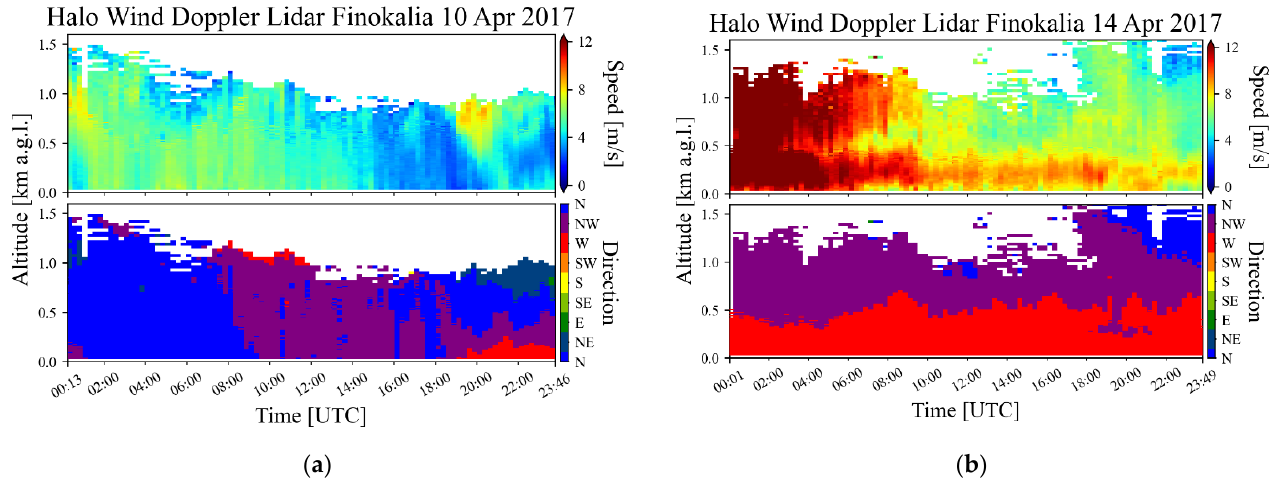
Figure 4 . Time-Height Cross Section of top: Wind Speed and bottom: Wind Direction from Halo Wind Doppler Lidar for ( a ) 10 April 2017, ( b ) 14 April 2017. Wind directions depicted in the color bar are classified in degrees as follows: [North: 0 ◦ , NW: 45 ◦ , W: 90 ◦ , SW: 135 ◦ , S: 180 ◦ , SE: 225 ◦ , E: 270 ◦ , NE: 315 ◦ , N: 360 ◦